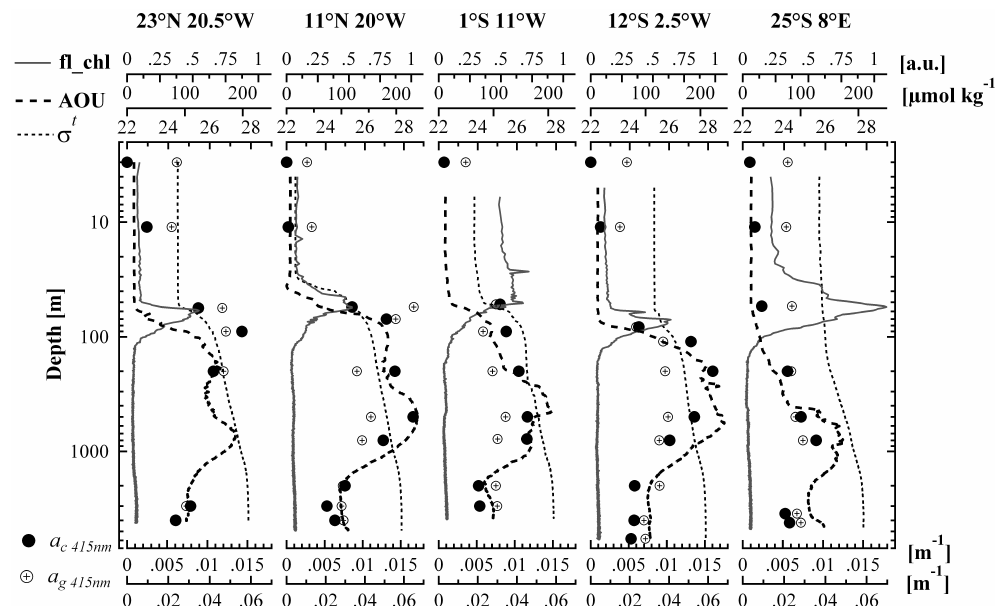
Fig. 3. Depth profiles of seawater density anomaly, σ t ; apparent oxygen utilization, AOU; chlorophyll a -like fluorescence, fl chl; the absorption of the 415-chromophore, a c 415 nm ; and the absorption of the remaining CDOM, a g 415 nm , i.e. a cdom minus a c . Shown are five profiles taken between 23 ◦ N and 25 ◦ S in the eastern Atlantic Ocean in November 2005